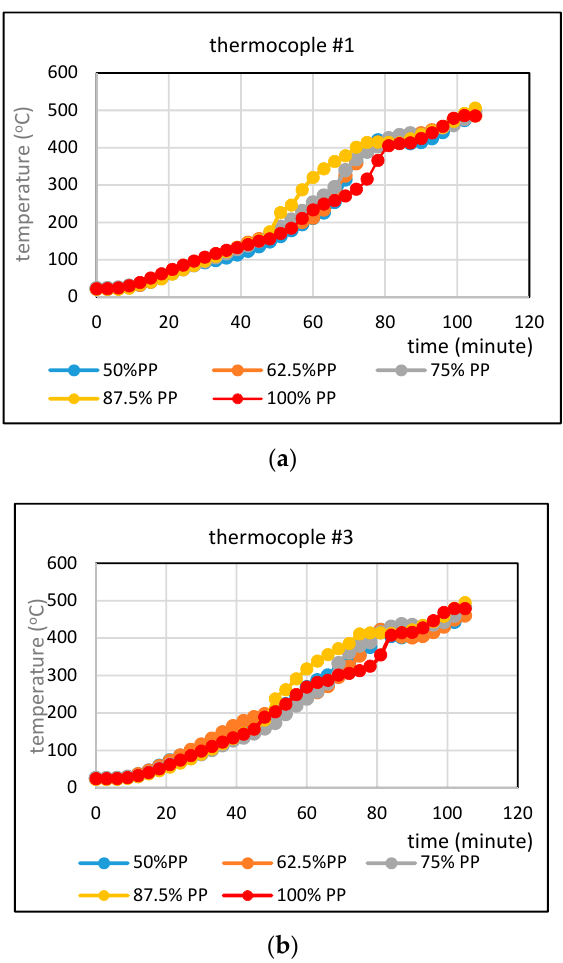
Figure 9. Temperature profile of pyrolysis fluid in regime 2 measured by Thermocouple #1 ( a ), Thermocouple #3 ( b ).